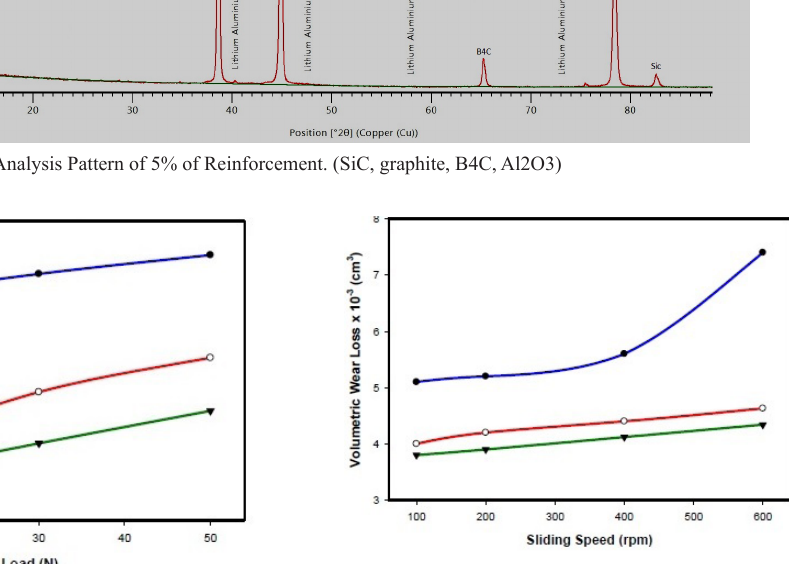
Figure 5. Volumetric wear loss of Al6061 alloy and Al6061 reinforcement composites at various sliding speeds and 50 N constant load; (Blue - aluminium sample; Red – aluminium with 4% of reinforcement composite sample; Green – Aluminium with 5% of reinforcement composite